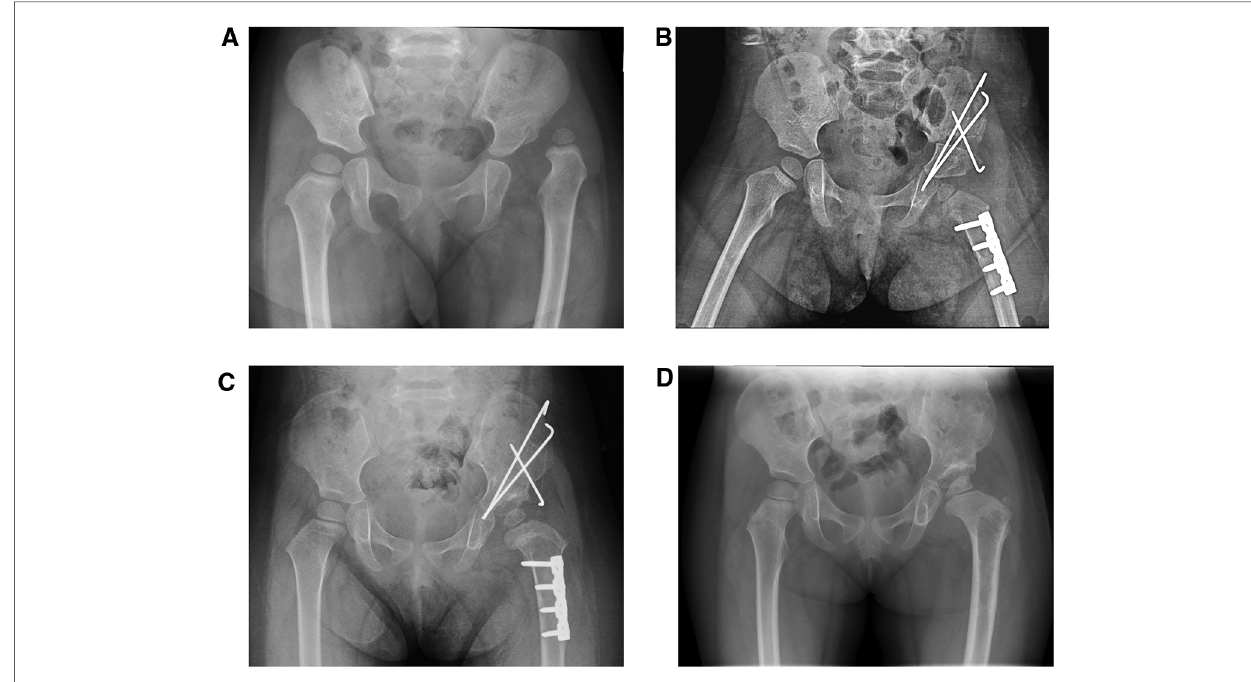
FIGURE 4 A girl, aged 2 years and 4 months, with Tönnis III dislocation of her left hip, underwent a Salter pelvic osteotomy combined with femoral shortening osteotomy. ( A ) Preoperative hip anteroposterior (AP) radiograph: left hip dislocation. ( B ) AP radiograph obtained one month after the Salter pelvic osteotomy combined with femoral shortening osteotomy. The length of the femur osteotomy was 1.5 cm. ( C ) AP radiograph obtained six months after the Salter pelvic osteotomy combined with femoral shortening osteotomy. ( D ) AP radiograph obtained 14 months after the Salter pelvic osteotomy combined with femoral shortening osteotomy and 6 months after removal of internal fi xation.